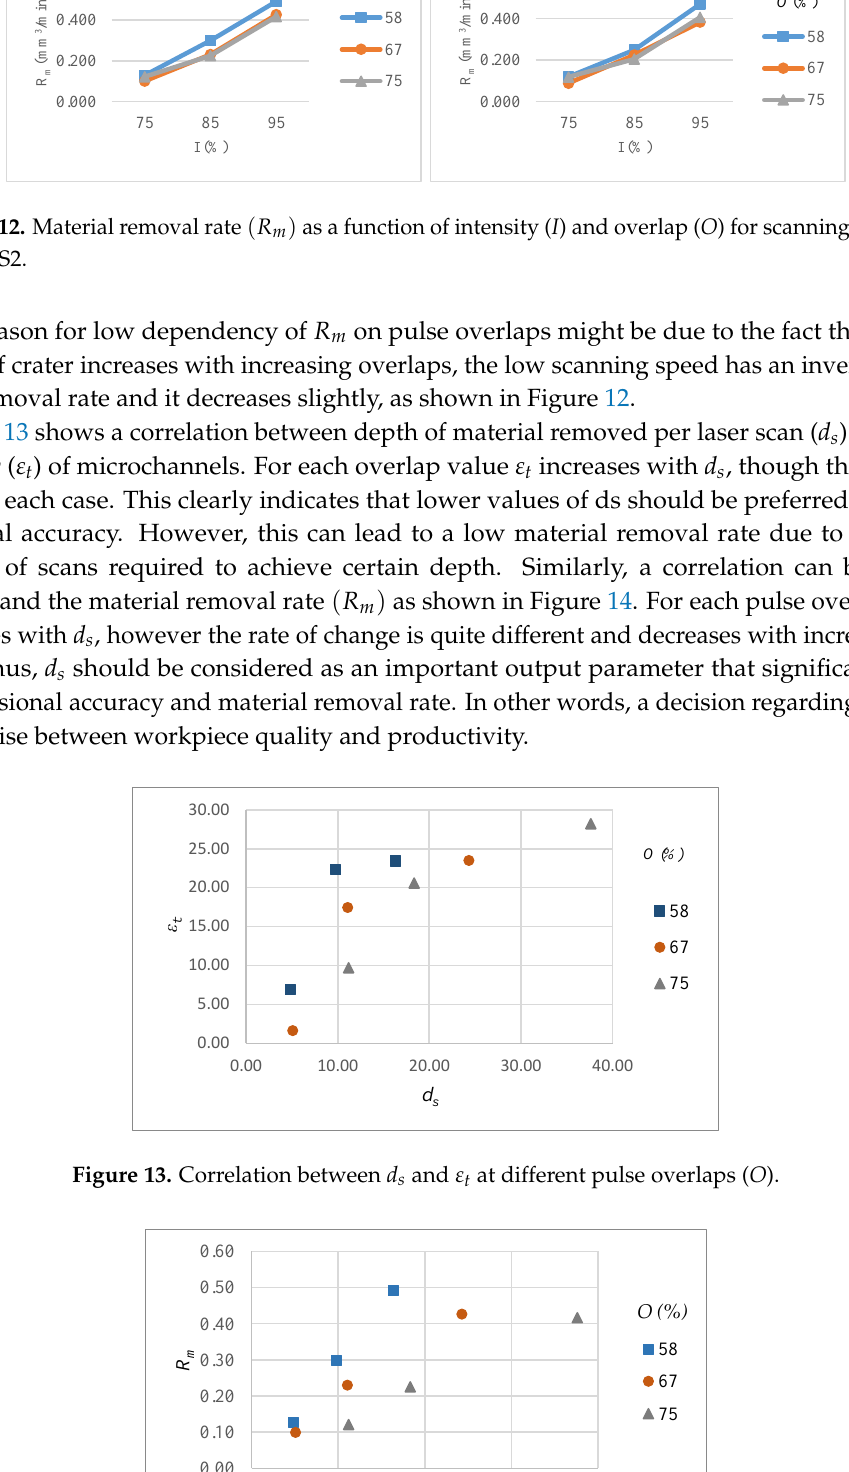
Figure 14. Correlation between d s and 𝑅 𝑚 at different pulse overlaps ( O ).